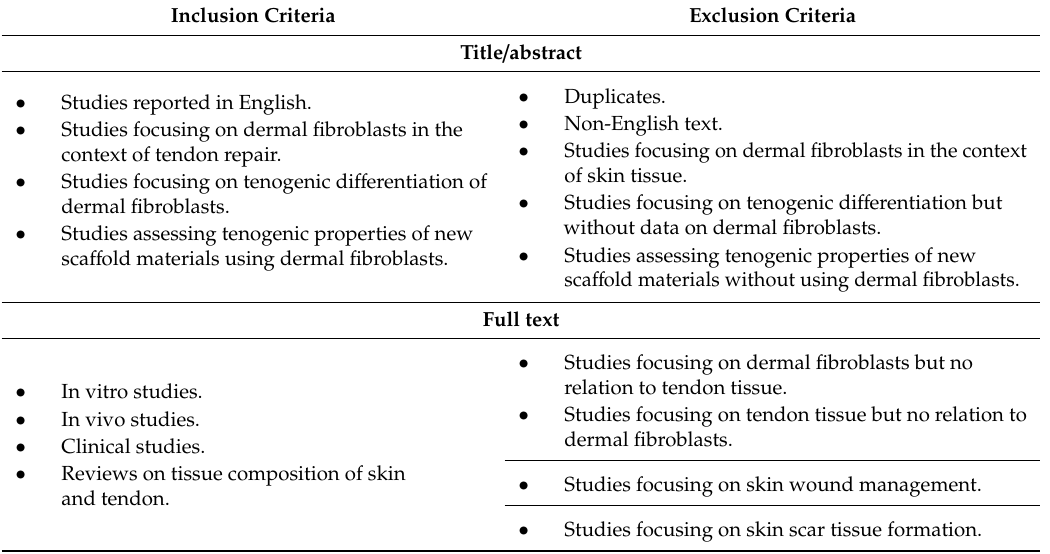
Table 1. Inclusion and exclusion criteria.